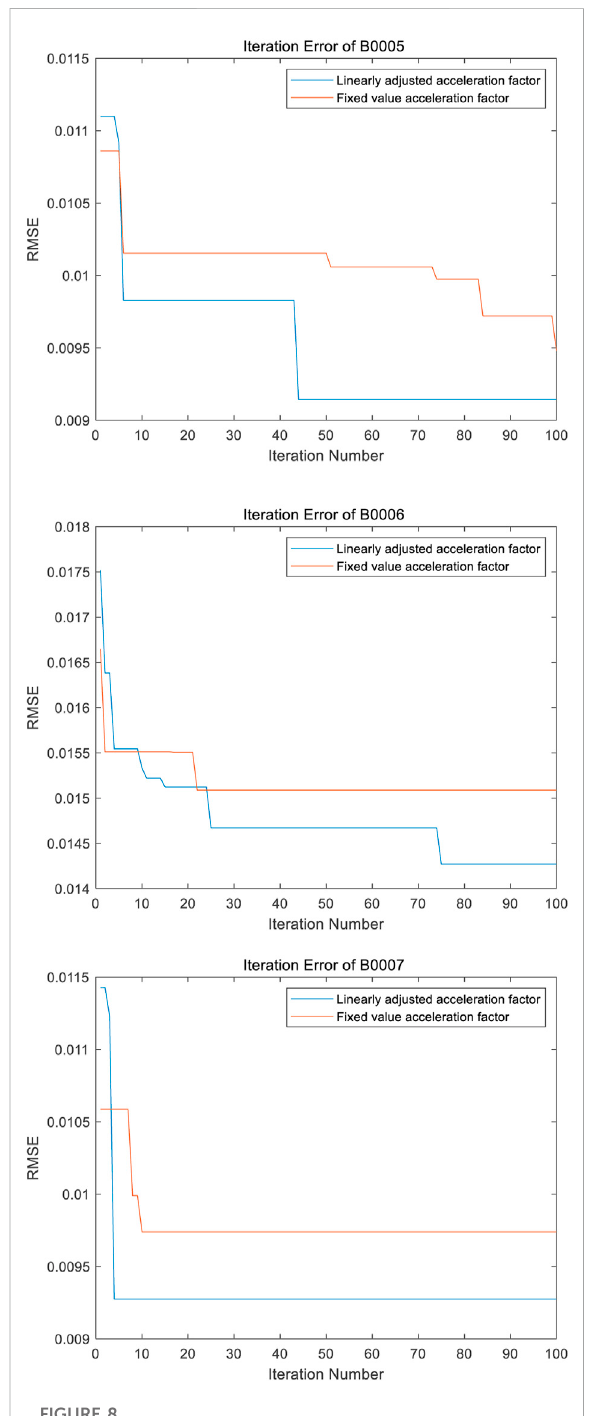
FIGURE 8 Acceleration factor comparison